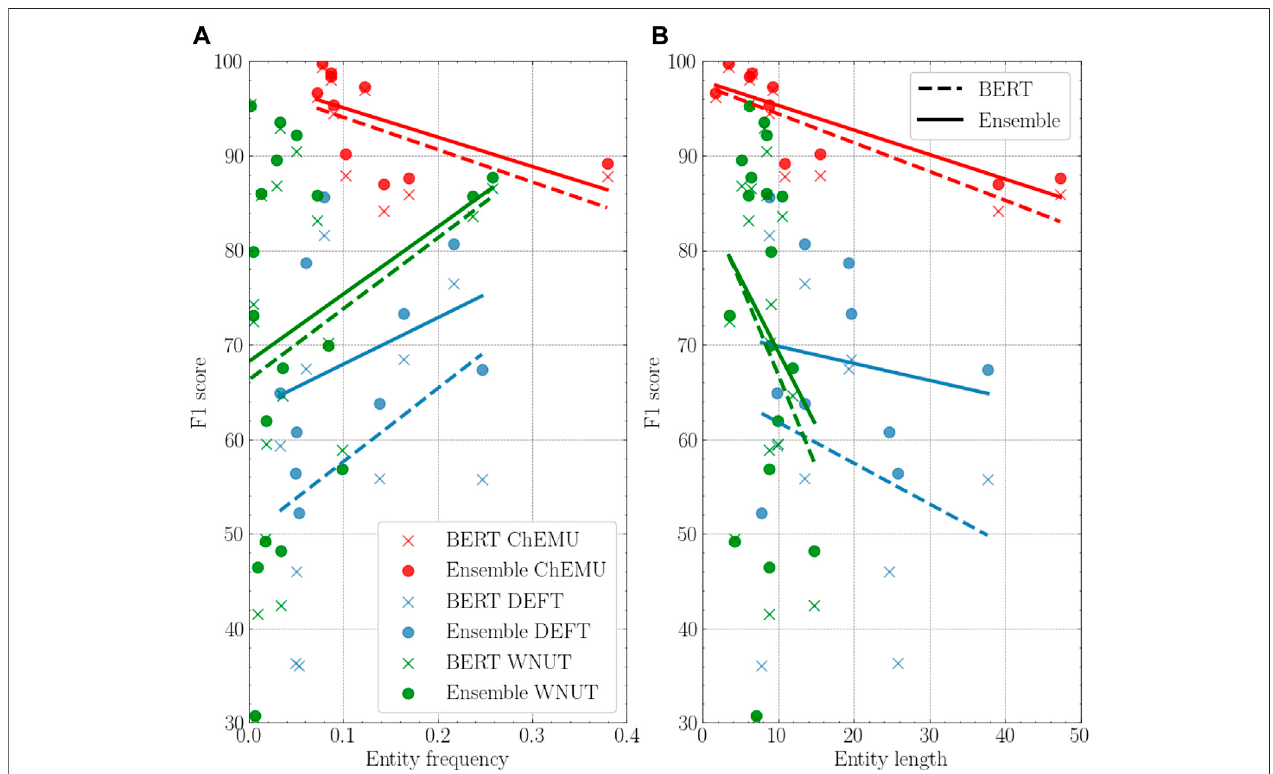
FIGURE 5 | (A) : Performance of the BERT model vs. the ensemble model based on the entity frequency on the training data. (B) : Performance of the BERT model vs. theensemble modelbased ontheentitylengthonthetraining data.Inboth,theindividual BERT forthethreedatasets isBERT-base-cased forChEMU, BERT-base- multilingual-cased for DEFT, and Bio + Clinical BERT for